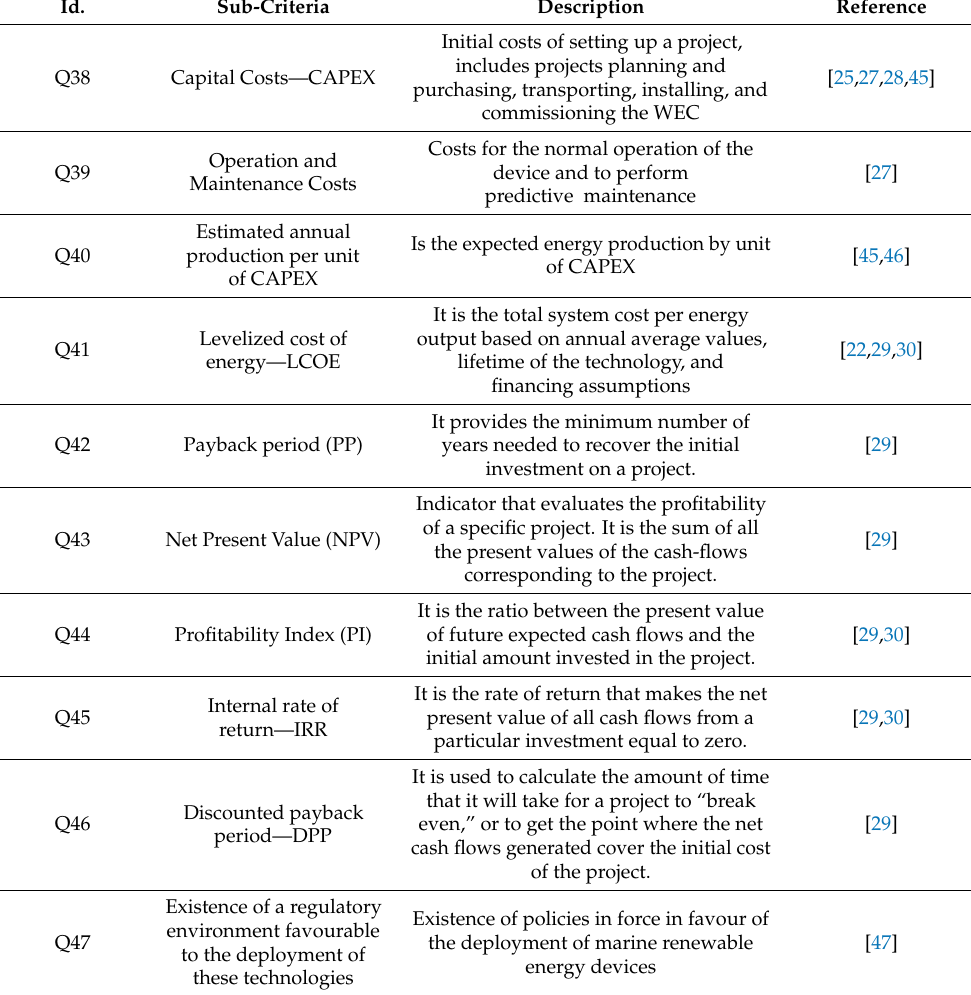
Table A10. Block 9: Influence of economic and cost-benefit performance factors. Q38 to Q47.